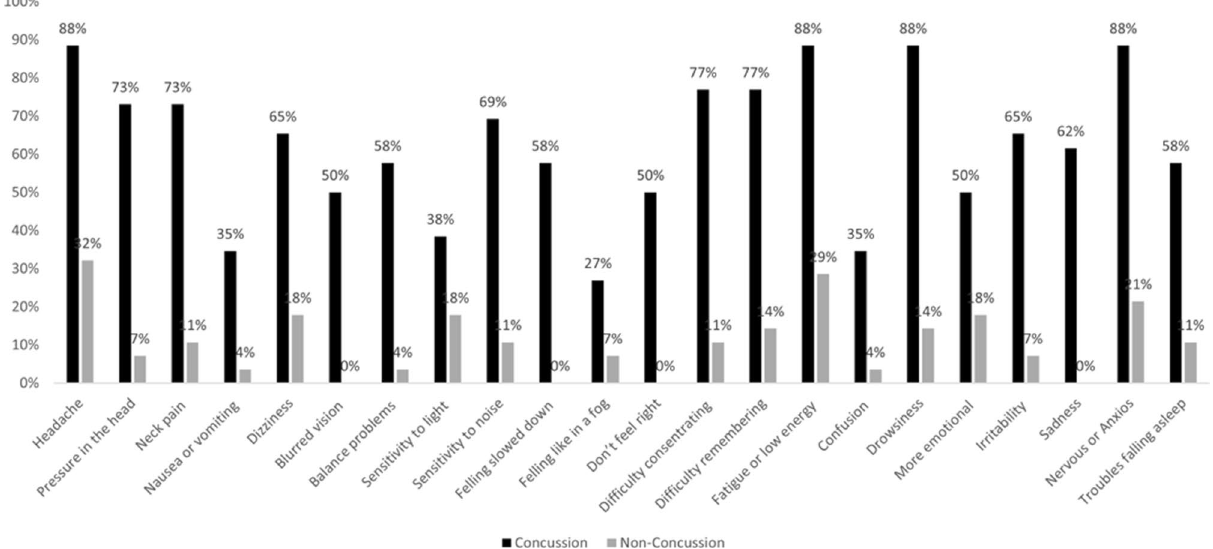
Figure 2. Symptoms (SCAT5) reported by all participants before and after VR acquisition. Overview of concussion symptoms reported by all participants before VR